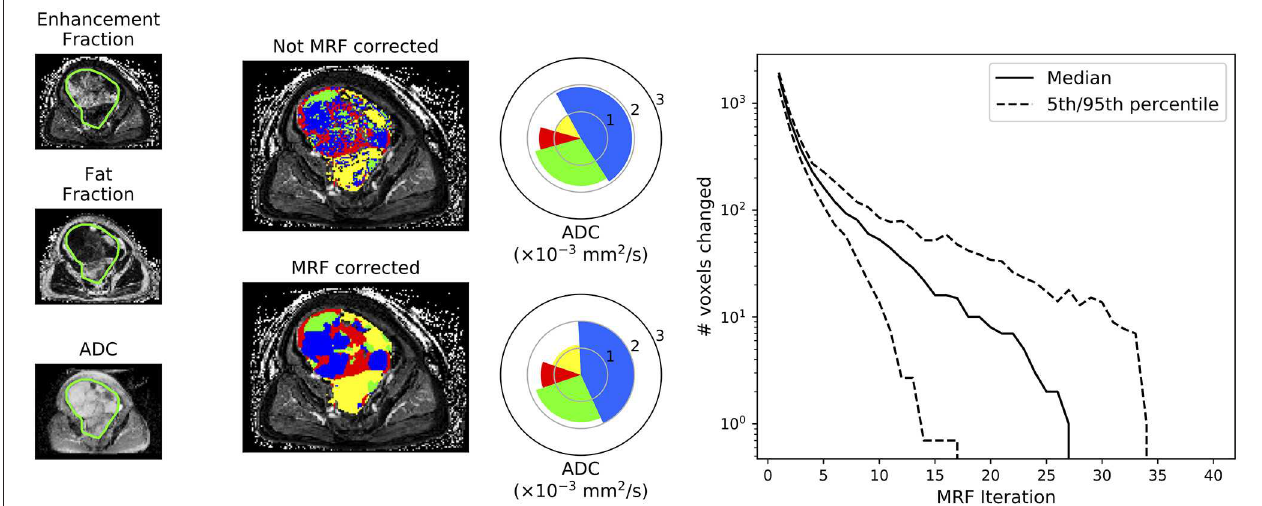
FIGURE 4 | Demonstration of the improvement to tissue sub-region classification following Markov Random Field (MRF) correction of the Naïve-Bayes classifier. This figure demonstrates results for the patient that was not included in the training of our machine-learning approaches (test data). Spie-charts (14) demonstrate the proportion of each tissue sub-compartment within the entire volume as the angle of each segment, whilst the mean ADC of each tissue sub-type is represented by the radius of each segment (note that the ADC of the fat/yellow tissue sub-type from fat-suppressed diffusion-weighted imaging studies should not be interpreted as it will be heavily noise-corrupted; only the proportion/angle of this tissue sub-type is informative). The far-right plot demonstrates the number of voxels that change classification following each iteration through the MRF fitting algorithm across all axial images in this patient: it is evident that the algorithm converges after a finite number of